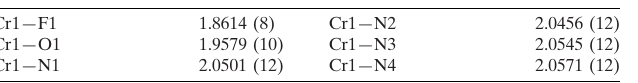
Selected bond lengths (A˚ ).